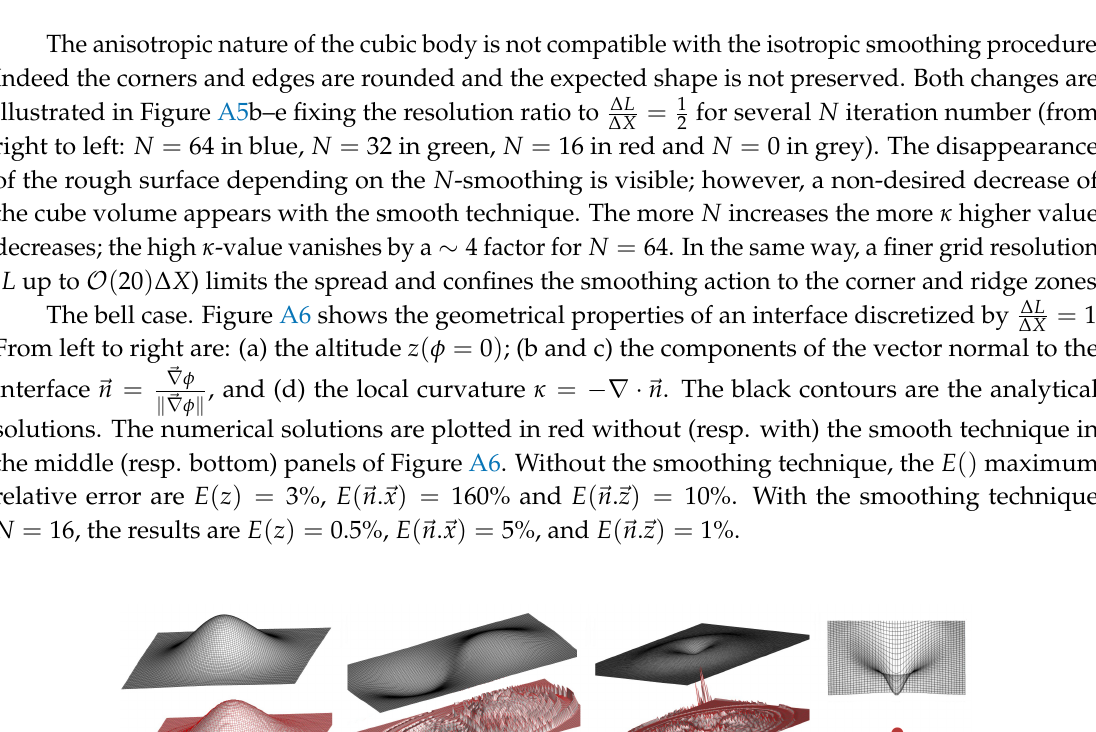
Figure A5. LSF generation: ( a ) Illustration of the discrete interface (in yellow) not correlated with the mesh. The φ = 0-contour is visualized with ( d ) N = 32; ( e ) N = 64 (cube case).